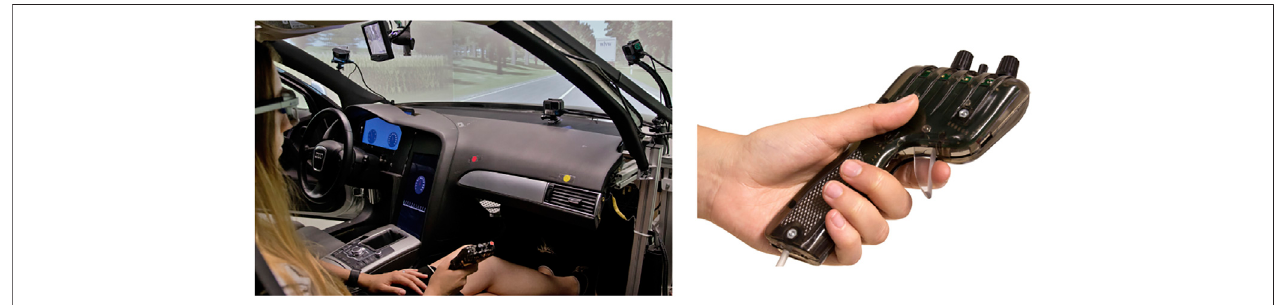
FIGURE 2 | Real-time assessment of passenger experience (discomfort) during automated driving (left) via handset control (right) .